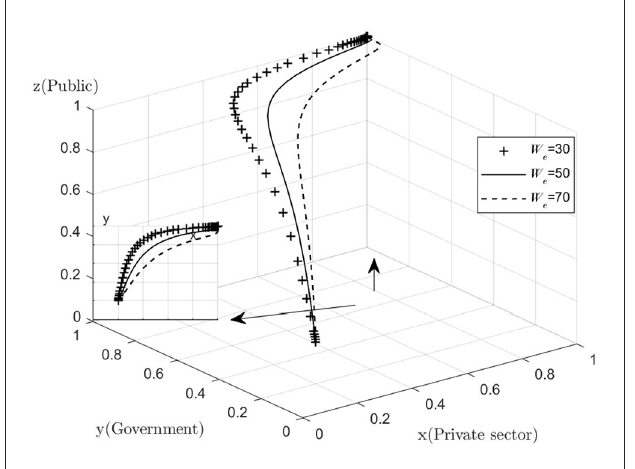
FIGURE6 Impact of positive regulatory costs.